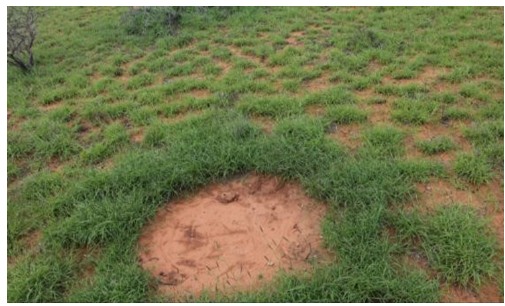
Figure 1. Pre-existing termite mound at Cape Range National Park,